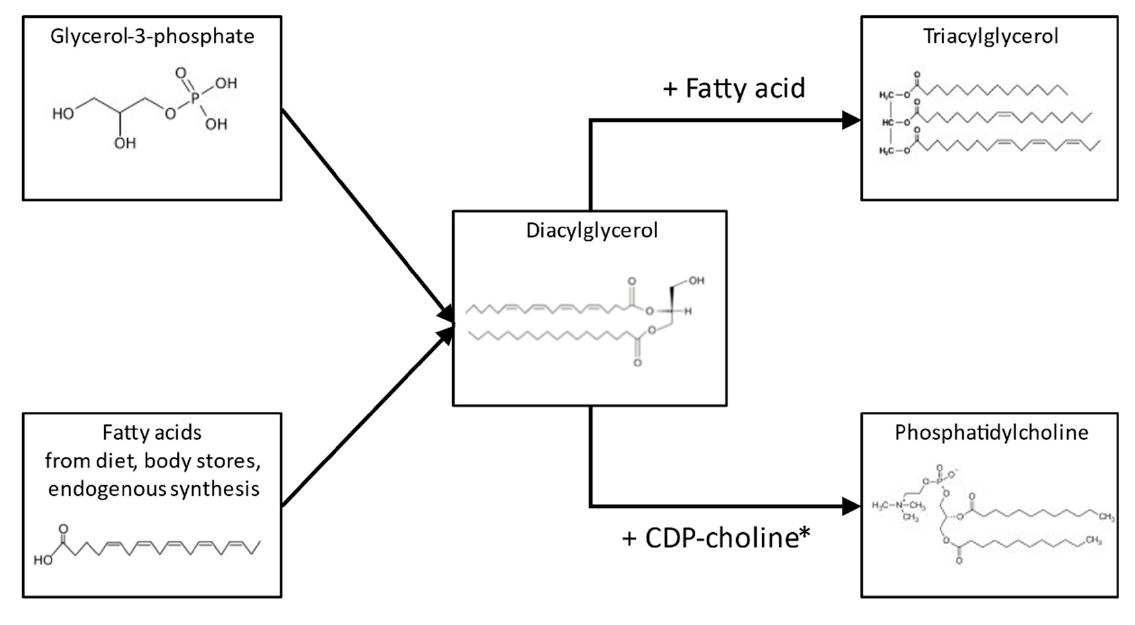
Figure 3. Simplified scheme (including examples of molecular structures) of the synthesis of triacyl- glycerols and phosphatidylcholines from fatty acid and glycerol-3-phosphate precursors, emphasizing the potential common intermediate diacylglycerol. *: Cytidine diphosphate choline.